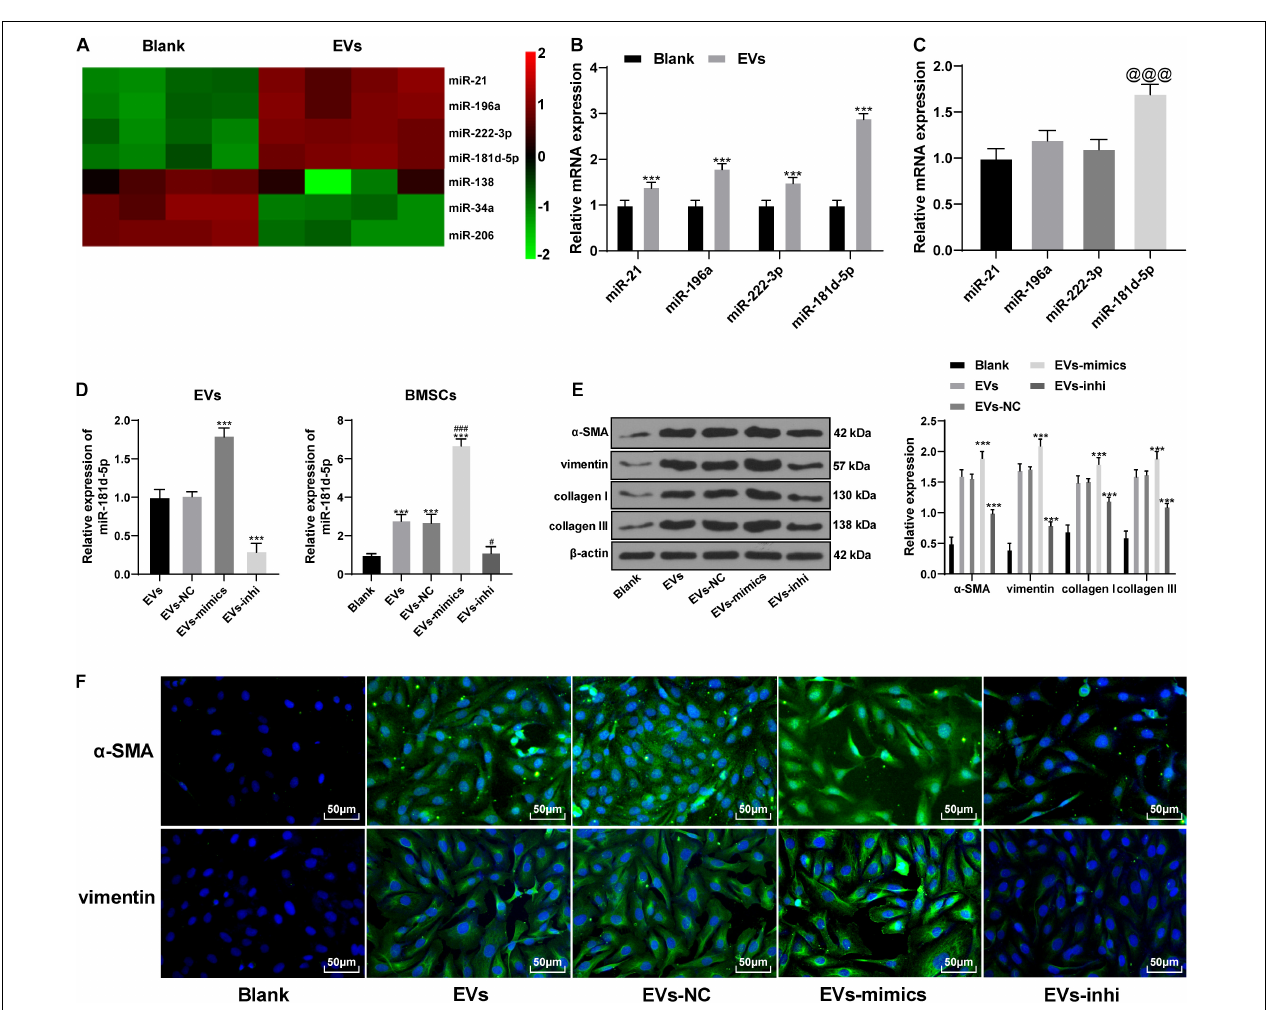
FIGURE 4 | Hepatoma cells-derived EVs promoted the differentiation of BMSCs by carrying miR-181d-5p into them. (A) The differentially expressed miRNAs in BMSCs before and after the action of EVs were analyzed by miR microarray. (B,C) miR expression in EVs-treated BMSCs (B) and in EVs (C) ; compared with the expression of miR-21 in EVs, the expression of miR-181d-5p was significantly increased, @@@ p < 0.001. (D) miR-181d-5p expression in EVs-mimic and EVs-inhi, and in BMSCs treated with EVs-mimic and EVs-inhi. (E) The levels of α -SMA, vimentin, collagen I, and collagen III in EVs-treated BMSCs were detected by Western blot analysis. (F) α -SMA and vimentin in EVs-treated BMSCs were detected by immunofluorescence. Compared with the blank group, *** p < 0.001; compared with the EVs group, # p < 0.05, ### p < 0.001. Data in panel (B) was analyzed by the t test, and data in panels C-E were analyzed by one-way ANOVA, followed by Tukey’s multiple comparison test. Replicates =